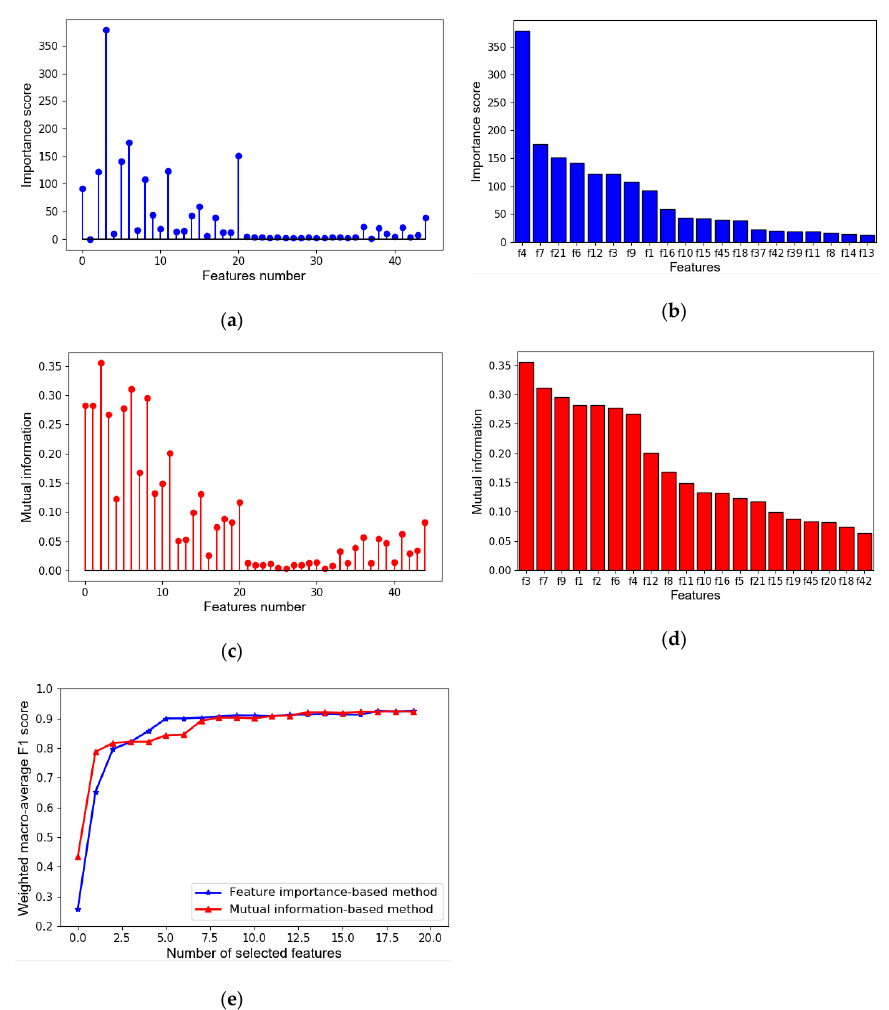
Figure 8. Illustration of feature selection based on different methods: ( a ) importance score of all the features; ( b ) importance score of the top 20 features; ( c ) mutual information of all the features; ( d ) mutual information of the top 20 features; ( e ) comparison of results of the two feature selection methods.